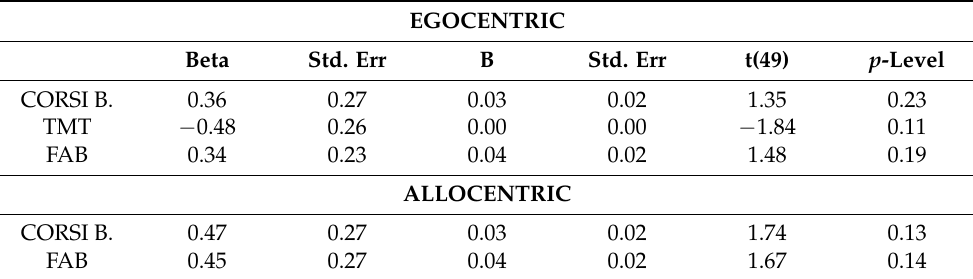
Table 3. The upper part of the table shows the relationship between aMCI participants’ performance at FAB, Corsi Backward, TMT (predictors) and accuracy of Egocentric judgments; the lower part of the table shows the relationship between participants’ performance at FAB and Corsi Backward and accuracy of allocentric judgments. The multiple regression parameters are reported.